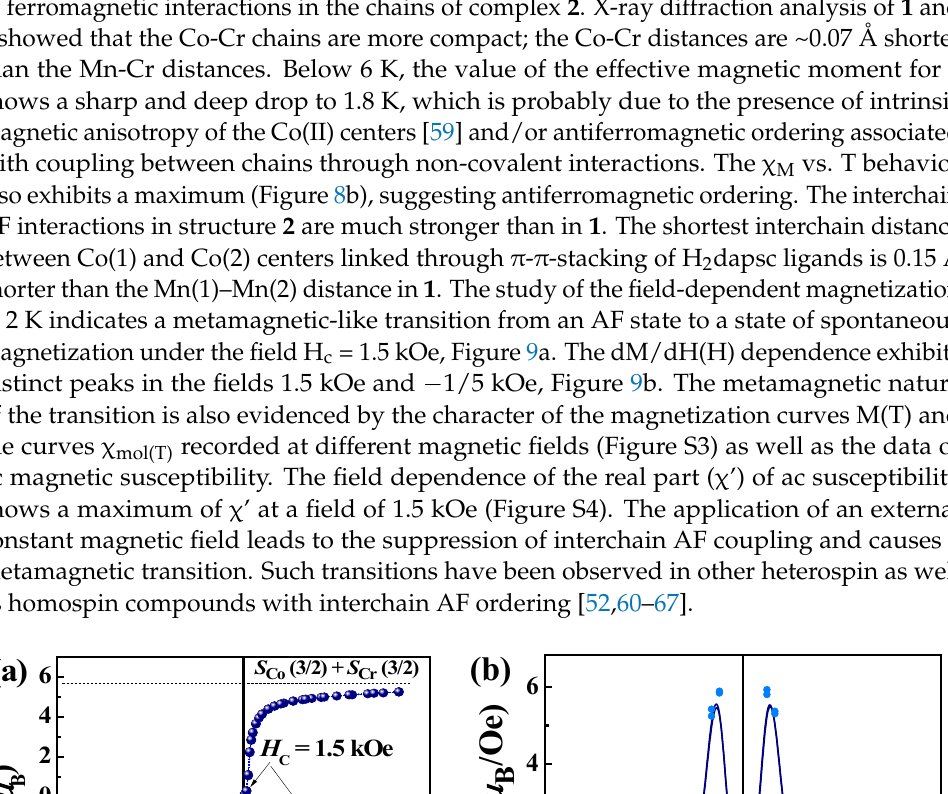
as homospin compounds with interchain AF ordering [52,60–67].